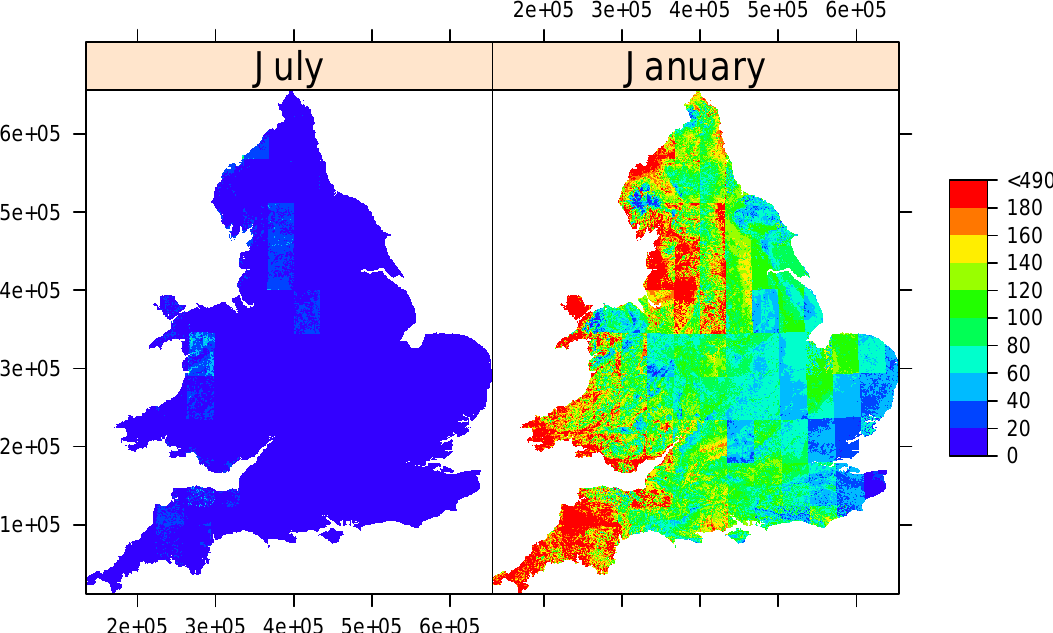
Fig. 8. Predicted potential monthly source of carbon (kg) efflux based on flow for a 1km grid across England and Wales (May and November). Coordinates are metres on the British National Grid. Note the maximum class limit is greater than the arithmetic scale used in the other classes.